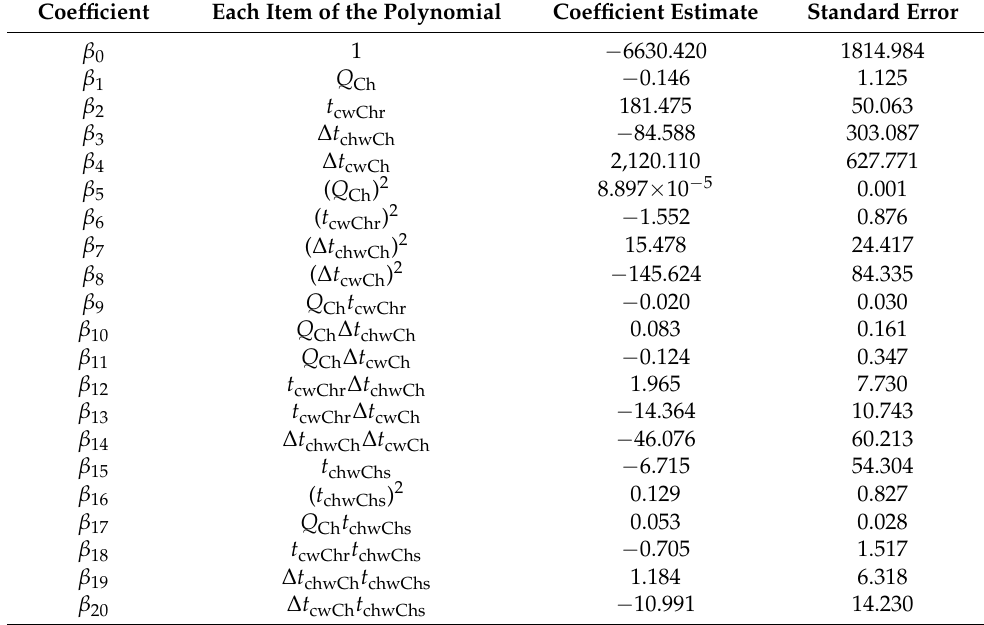
Table 5. Fitting results of the energy-consumption for chiller 1(Ch-1) in cooling